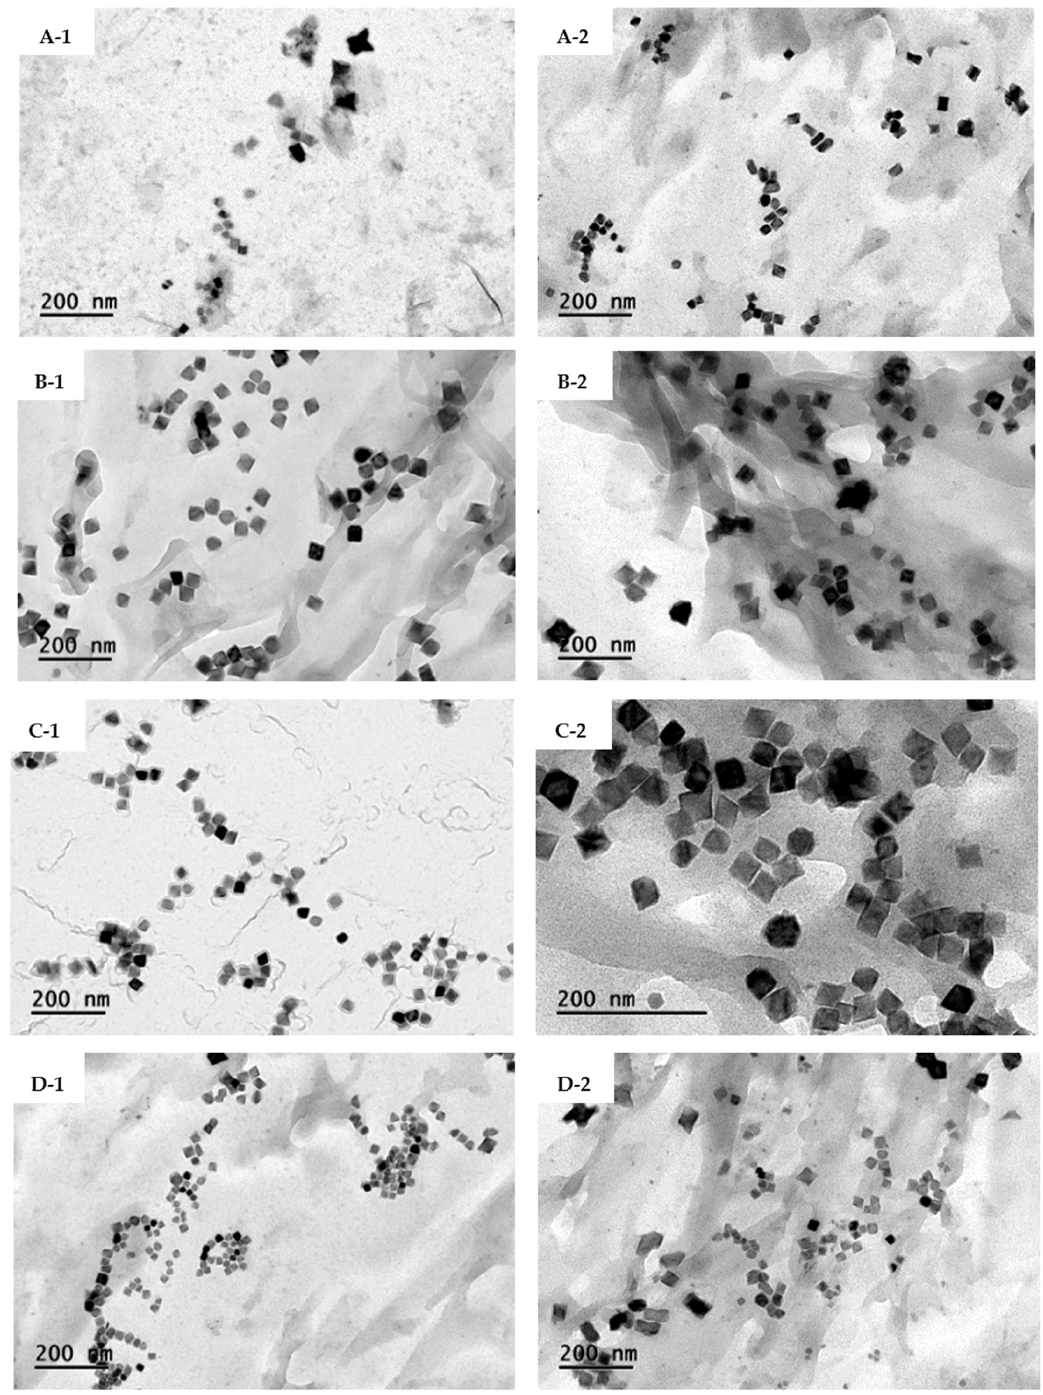
Figure 11. Micromorphology of precipitated phases containing Nb at 1373 K and 1473 K. Micromor ‐ phology of Nb ‐ containing precipitates ( A – D ) of ( A ‐ 1 – D ‐ 1 ) samples at 1376 K. Micromorphology of Nb ‐ containing precipitates ( A – D ) of ( A ‐ 2 – D ‐ 2 ) samples at 1473 K.